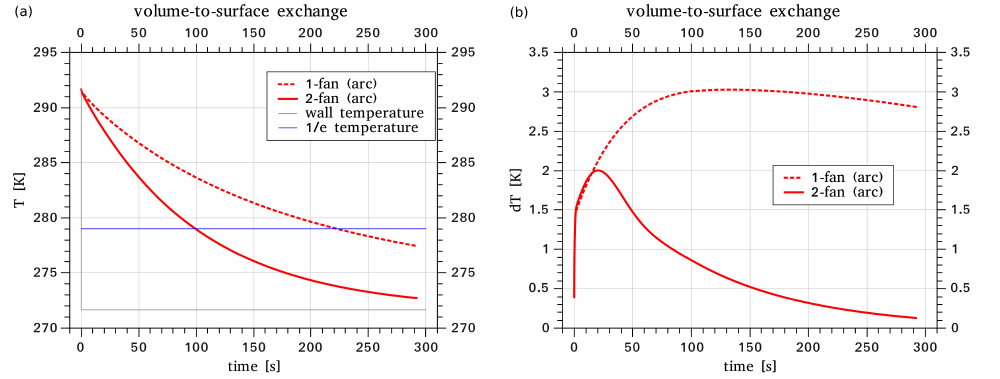
Fig. 8. Results of the simulations investigating volume-to-surface exchange in the CLOUD chamber. Shown are the temporal development of T (a) and δT (b) for an instantaneous drop of wall temperature by